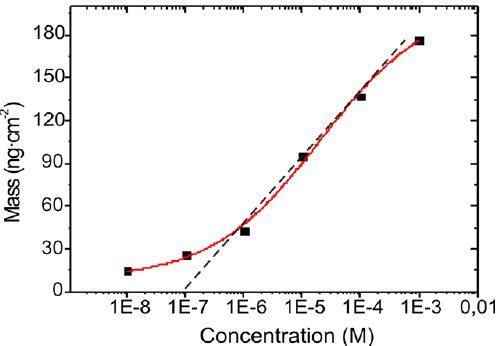
Figure 7. Relationship between the adsorbed mass of HSA protein in the surface and the HSA solution concentration. The dash line shows a linear fit for the dynamic range of the